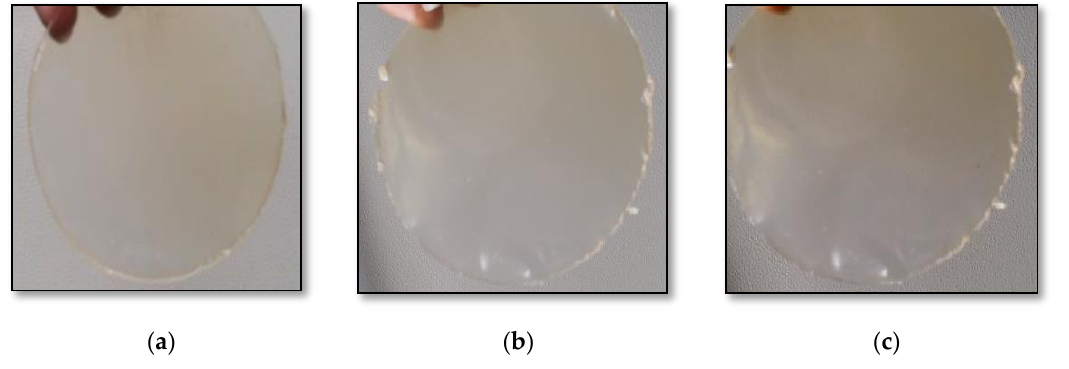
Figure 2. Images of edible films: ( a ) test-1; ( b ) test-2; ( c ) control.